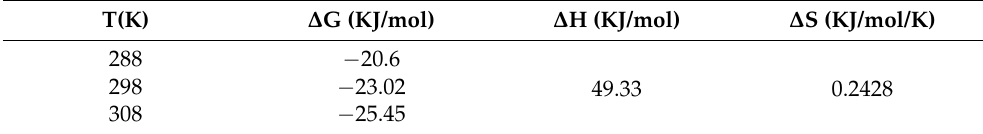
Figure 5. ( a ) The maximum adsorption capacity for Cu 2+ with different cellulose-based adsorbents was compared with CMCNFs-PEI aerogels: Cu 2+ adsorption capacity in this work, pomelo peel car- boxylated cellulose nanofibers-PEI (POCNF-PEI) [24]; polydopamine-CNF-PEI (PDA-CNF-PEI) [25]; carboxymethylated CNFs (CMCNF-2.7) [26]; NFC/PEI composite aerogel (NPAs) [15]; NFCs/poly(2-(dimethylamino) ethyl methacrylate) interpenetrating network hydrogels (NPIHs) [27]; cellulose nanowhiskers (CNWs) [28]. ( b ) Effect of temperature on the Cu 2+ adsorption of CMCNF30-PEI. Table 4. Thermodynamic parameters of CMCNF30-PEI adsorption for Cu 2+ . T(K) ∆ G (KJ/mol) ∆ H